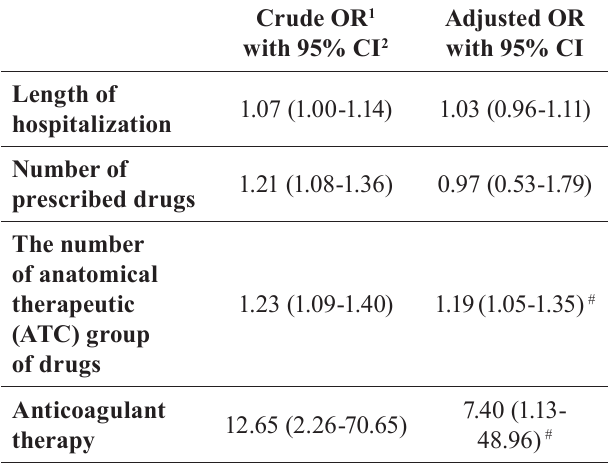
TABLE IIB - Predictors of pCDDIs